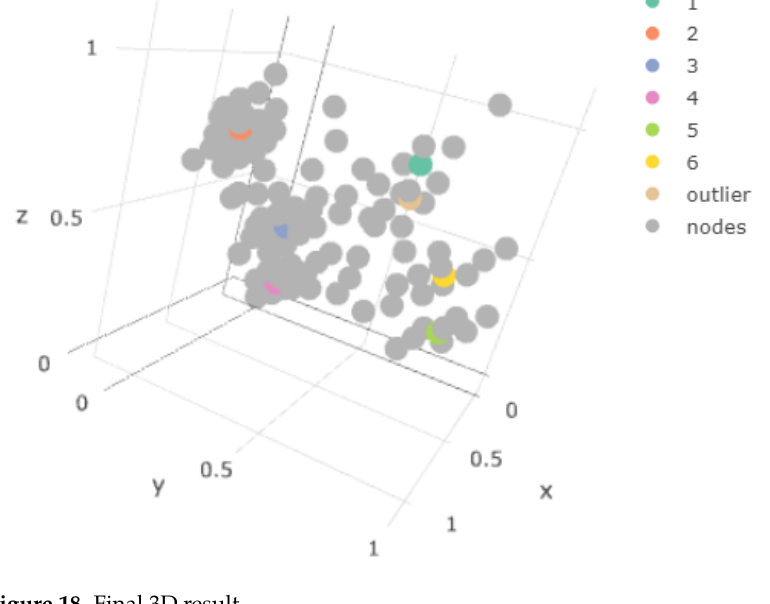
Figure 18. Final 3D result.